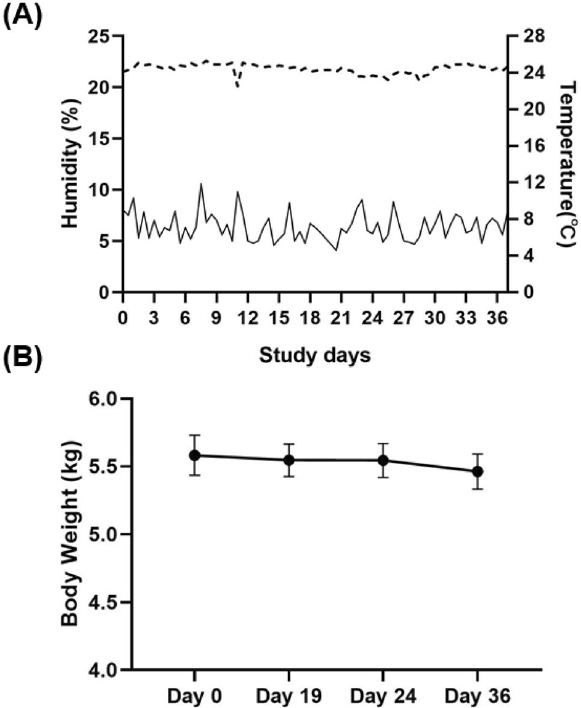
Figure 1. Monitoring of environmental conditions and body weight of the primates. ( A ) The relative humidity (%) and temperature of the controlled environment room throughout the study. ( B ) The body weight of the monkeys during the